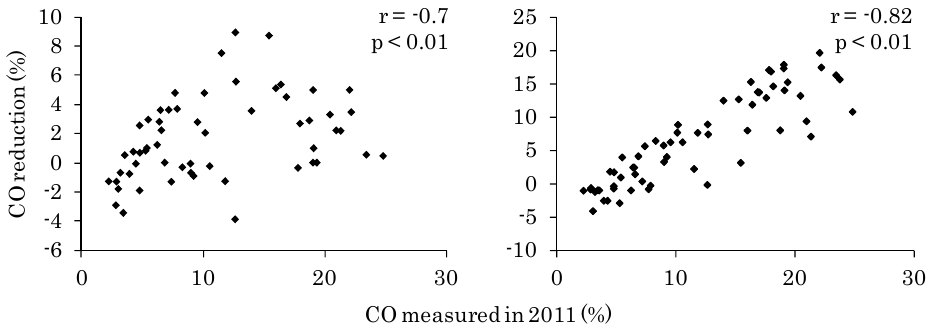
Figure 5. Correlation between the initial CO measured in 2011 and the CO reduction to 2012 ( left ) and 2014 ( right ). The correlations were tested using Spearman’s method.